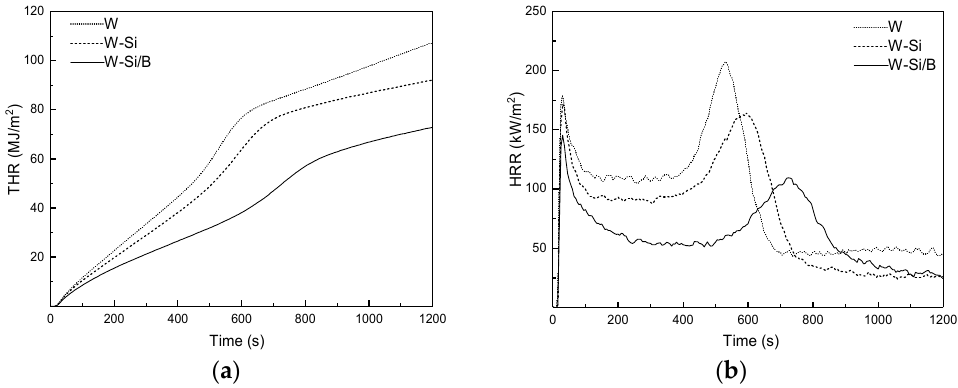
Figure 2. The ( a ) total heat release and ( b ) heat release rate during the cone calorimetric test.